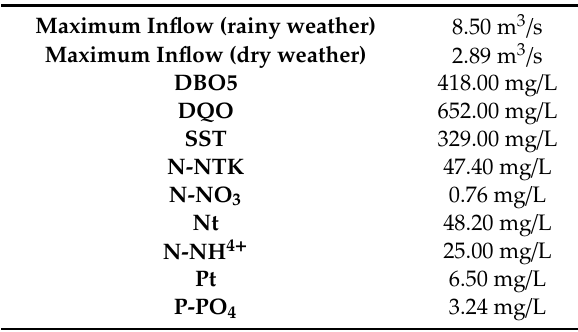
Table 1. Design parameters of wastewater treatment plant of Villap é rez (Asturias,